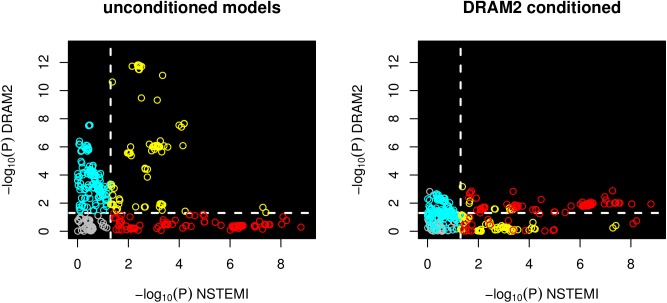
Association of genetic variants at 1p13.3 with DRAM2 expression and NSTEMI.P-values for association with DRAM2 expression are presented both for the basic model (left-hand side) and the model conditioned for rs325927 (right-hand side). The white dashed lines are drawn at P = 0.05 and divide the areas into quadrants. The variants are colored based on the quadrant they fall into under the unconditioned analysis model.